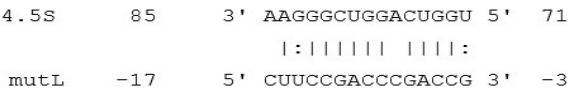
Figure 10. It is worth noting that the base pairing between the 4.5S and the mRNA mutL start at the